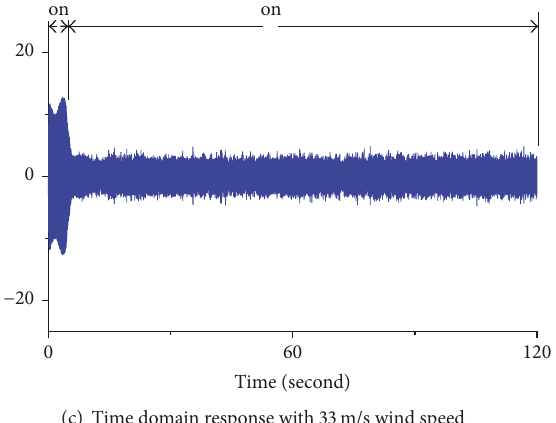
Figure 10: Time domain response of closed-loop